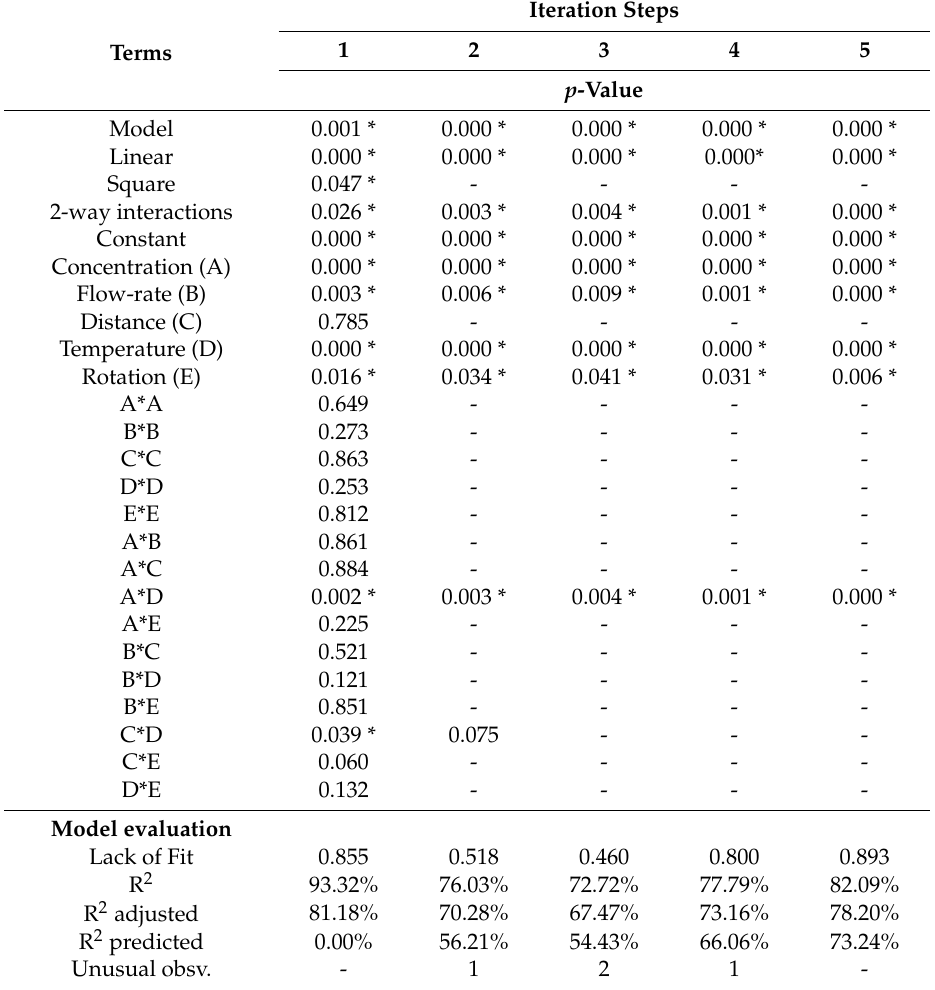
Table 4. Summary of response surface analysis for elastic